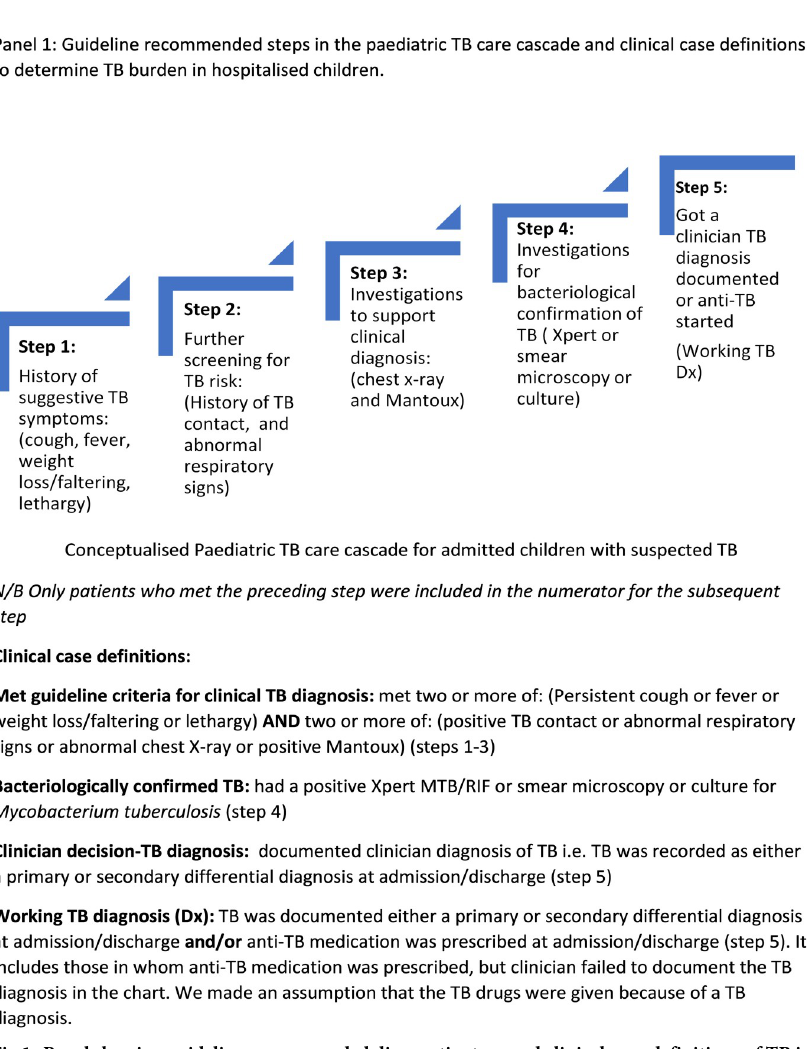
Fig 1. Panel showing guideline-recommended diagnostic steps and clinical case-definitions of TB in the study.